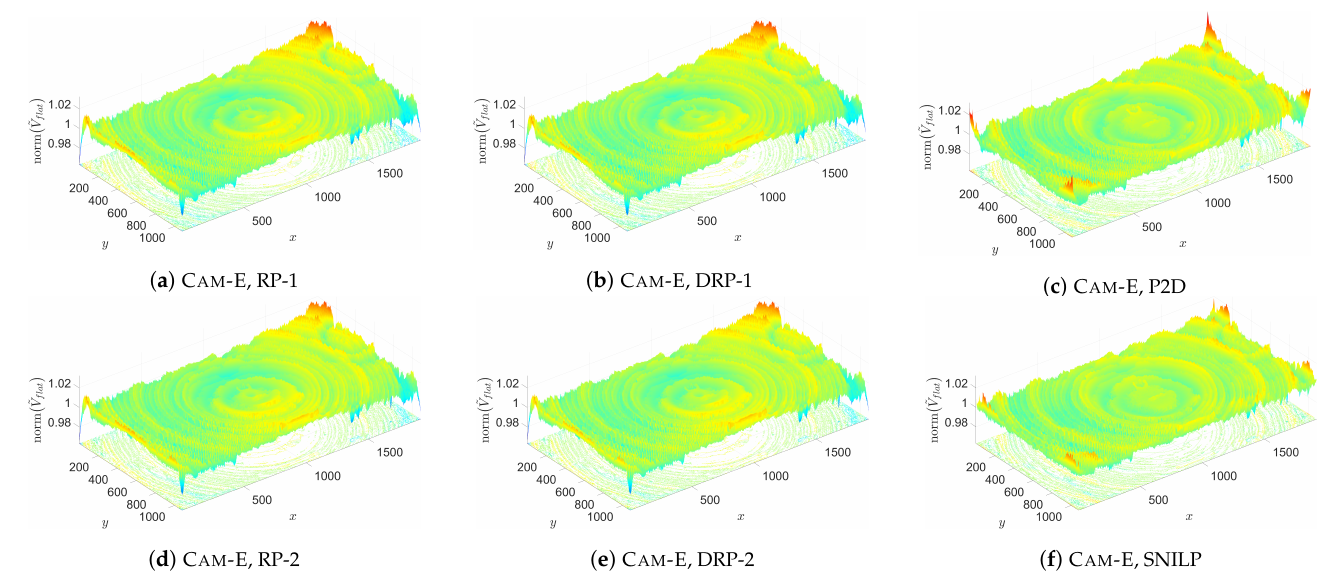
Figure A10. Comparison of vignetting corrections of flat-field image I V for C AM